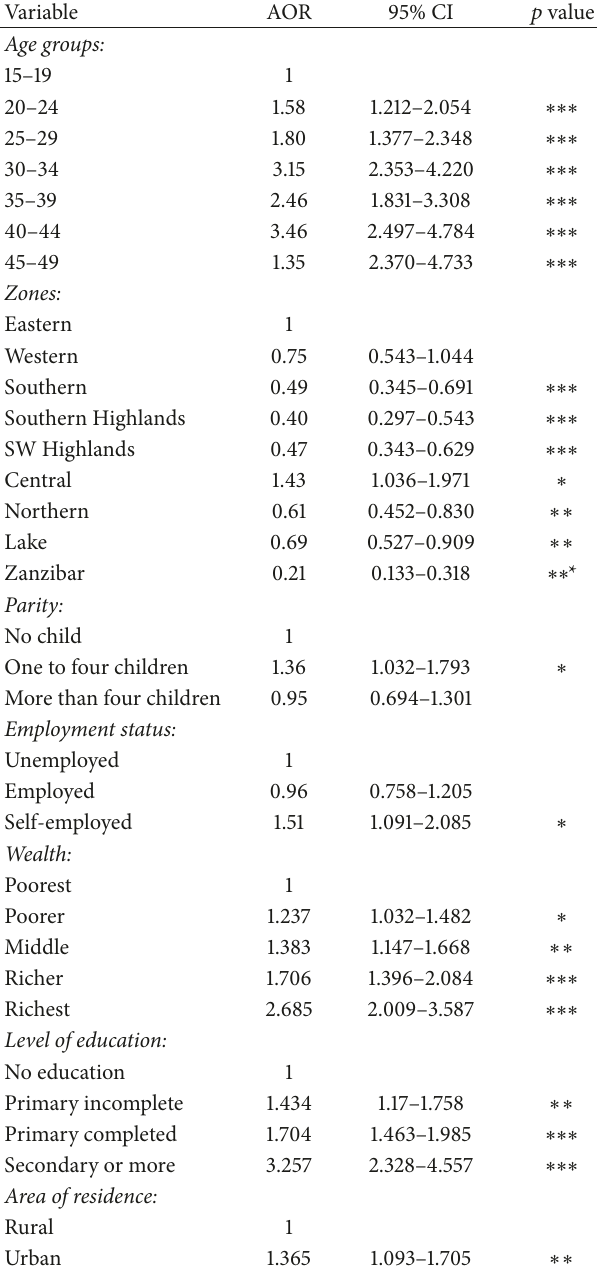
Table 3: Adjusted odds ratios (AOR) for factors associated with awareness about cervical cancer among women of reproductive age (15–49 yrs) in Tanzania 2011-2012 ( 𝑁 = 5543